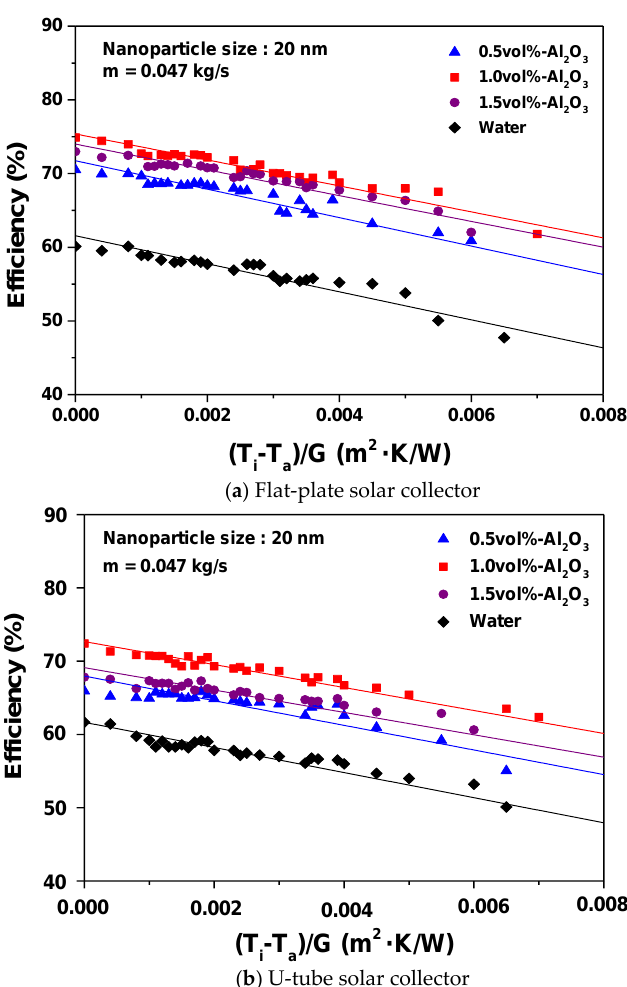
Figure 4. Efficiency variations in the solar collector for various nanofluid concentrations: ( a ) Flat-plate solar collector; ( b ) U-tube solar collector. Table 4. Solar radiation and average environmental temperature in a month (Gwangju, Korea).